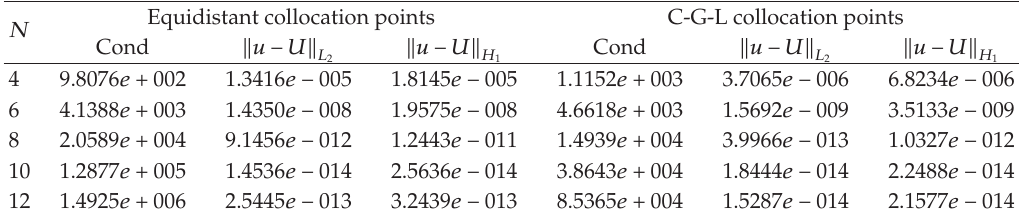
(cid:4) 10, β (cid:4) 100 (cid:6) . 1 2